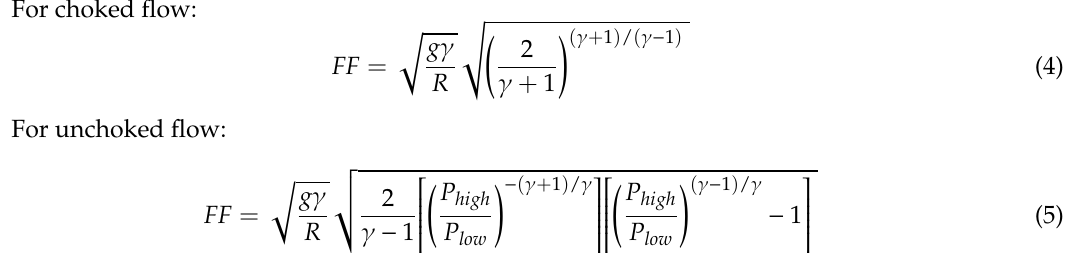
Figure 14. Normalized equivalent gap data (offset and mismatch condition).